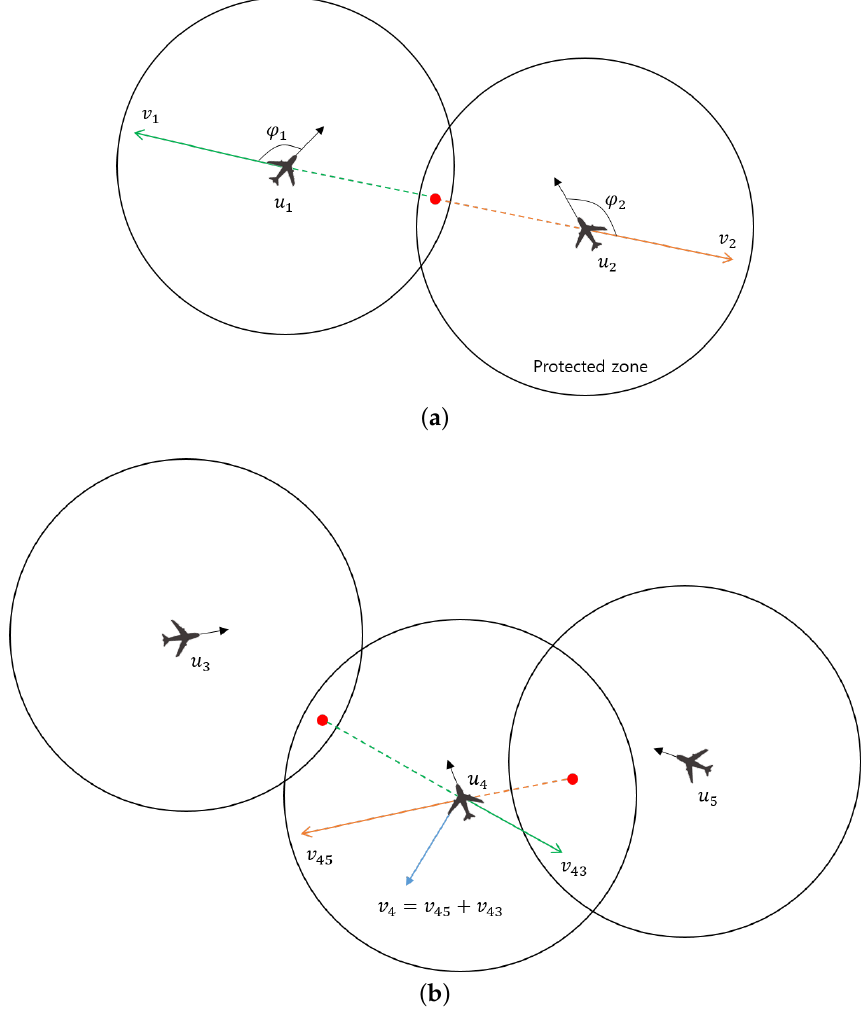
Figure 4. Examples of generating guidance vectors: ( a ) Two UAVs; and ( b ) three